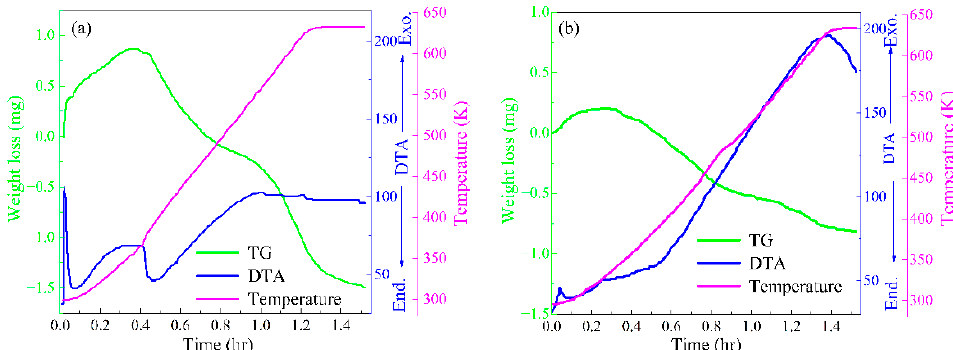
Figure 1. TG-DTA curves of sample prepared by heating the gel at 773 K ( a ) and 973 K ( b ) under CO 2 atmosphere.